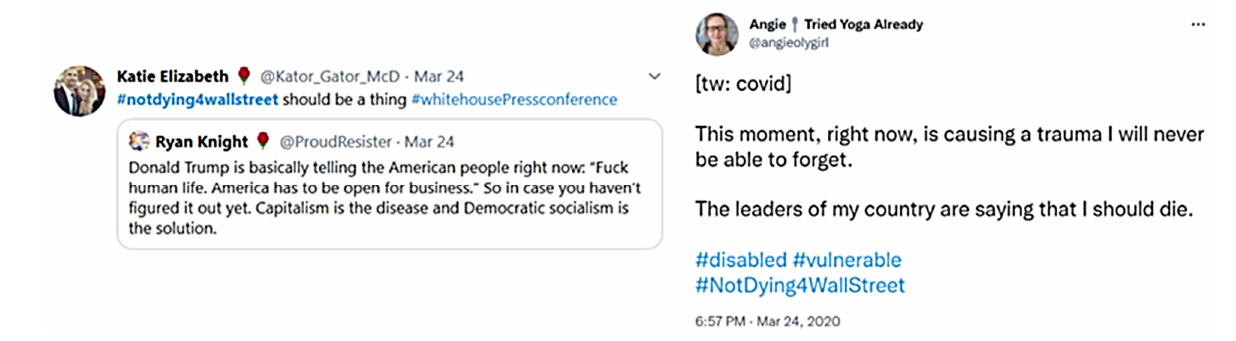
Figure 1. Emergence of #NotDying4Wallstreet [4] and a personal reaction to the discussion